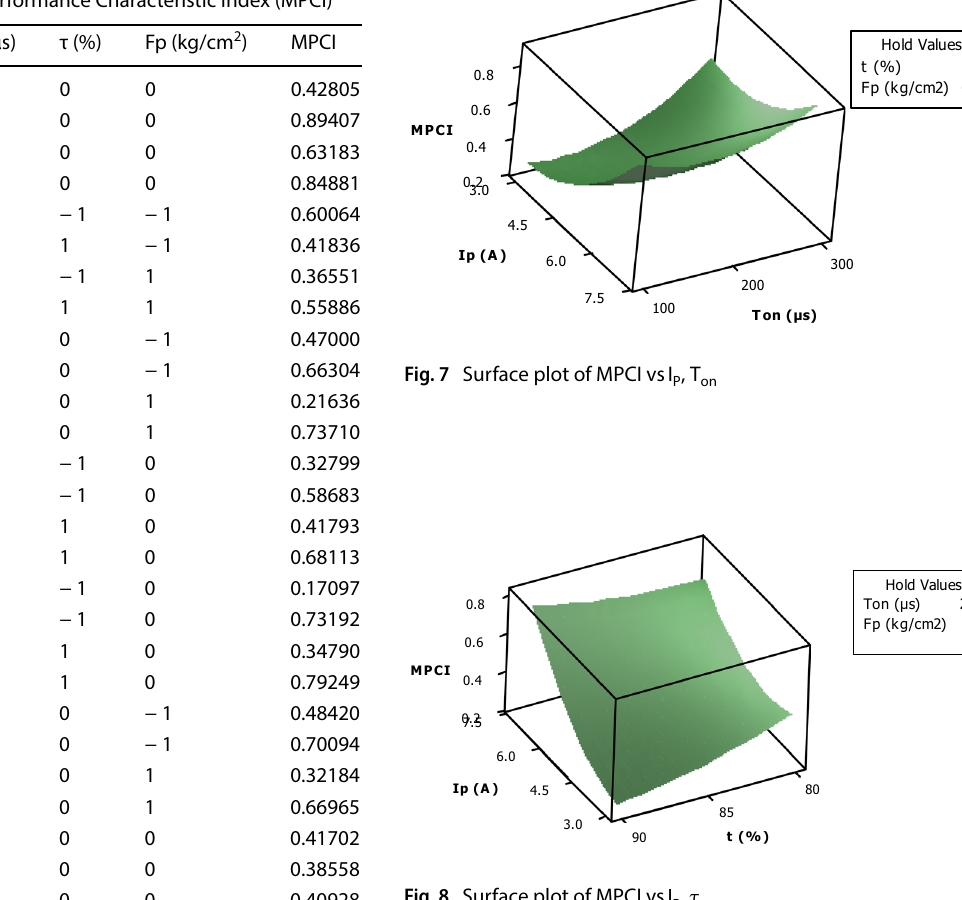
Fig. 8 Surface plot of MPCI vs I P ,